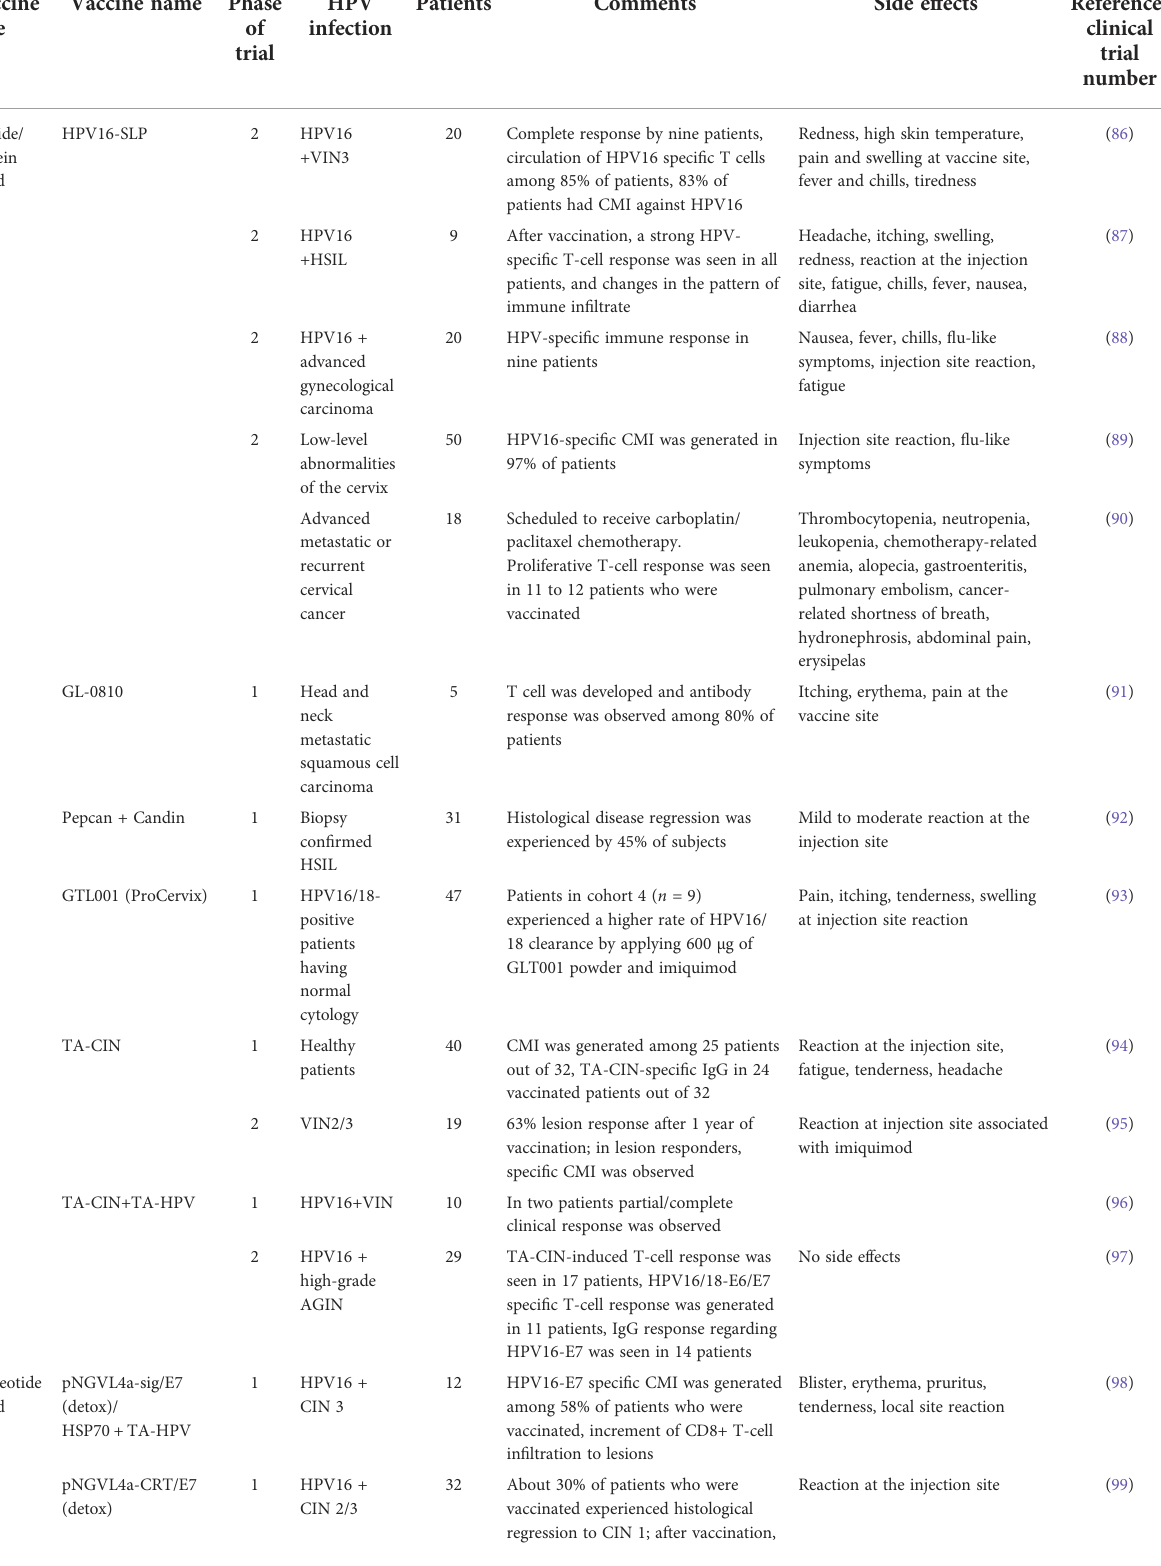
TABLE 2 Clinical signi fi cance of different types of vaccines against HPV infection. Vaccine